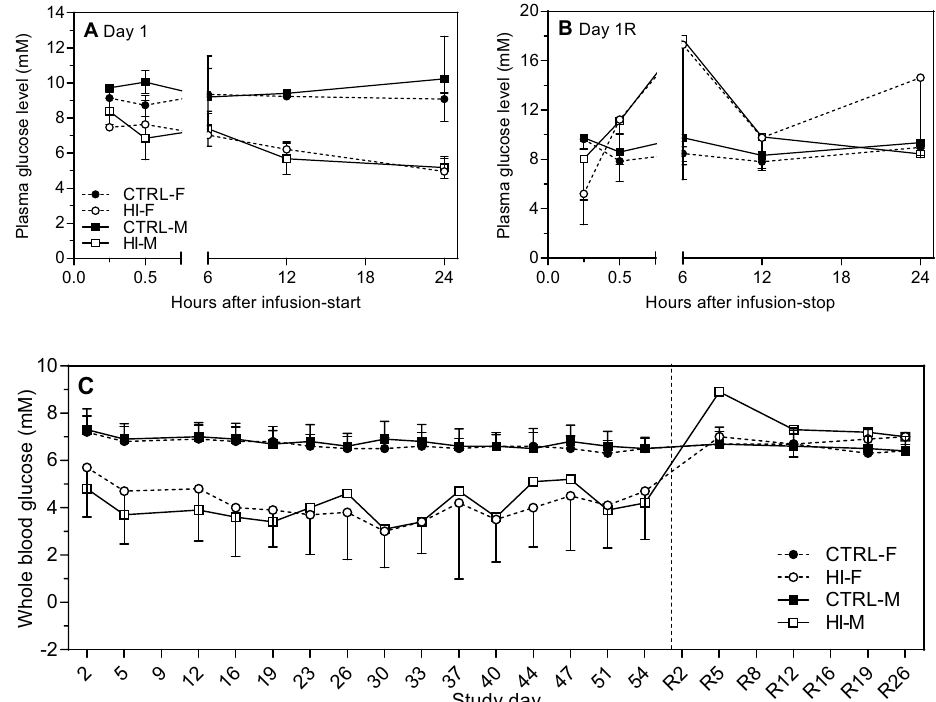
Figure 2. Blood glucose during and after infusion. Modified from 20 . ( A ) Plasma glucose levels after infusion- start on Day 1, n = 2/sex/time-point. ( B ) Plasma glucose levels after infusion-stop, i.e. Day 1 of recovery (Day 1R), n = 2/sex/time-point except in group HI-M at 12 h and 24 h: n = 1 (thus no SD for these time-points). ( C ) Whole blood glucose levels throughout the study, dashed line indicates infusion-stop. Day 2–23, n = 28–38/ group; Day 26–51, n = 22–28/group; Day 54, n = 12–17/group; after infusion-stop (recovery period), n = 5–10/ group. R,